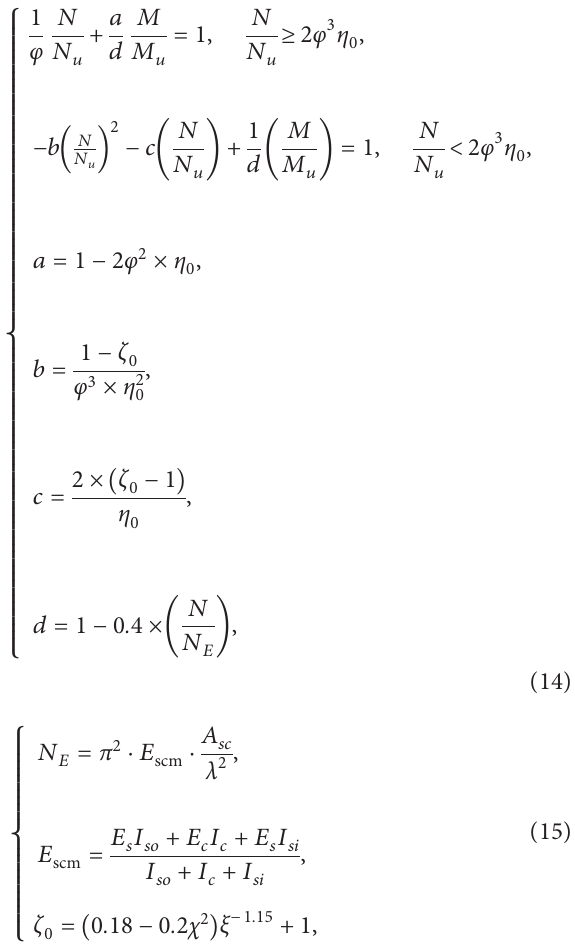
j curves under different hollow